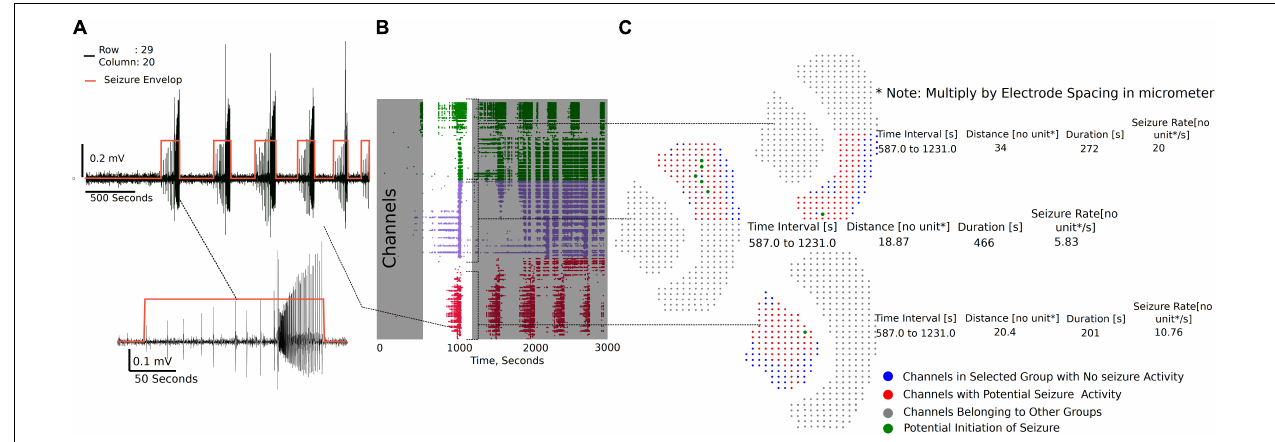
FIGURE 6 | Seizure activity tracking over space and time. (A) Seizures in individual channels in a group are automatically detected. Their respective start and end times can be tracked across channels in that group. (B) Regions of the raster between time intervals can be selected as demonstrated to generate seizure maps of selected brain regions within the interval. (C) Seizure map for the time interval selected and channels in the group, including initiation site of the seizure, maximum distance the seizure spread from the initiation point, duration of the seizure, and the rate of seizure spread across the